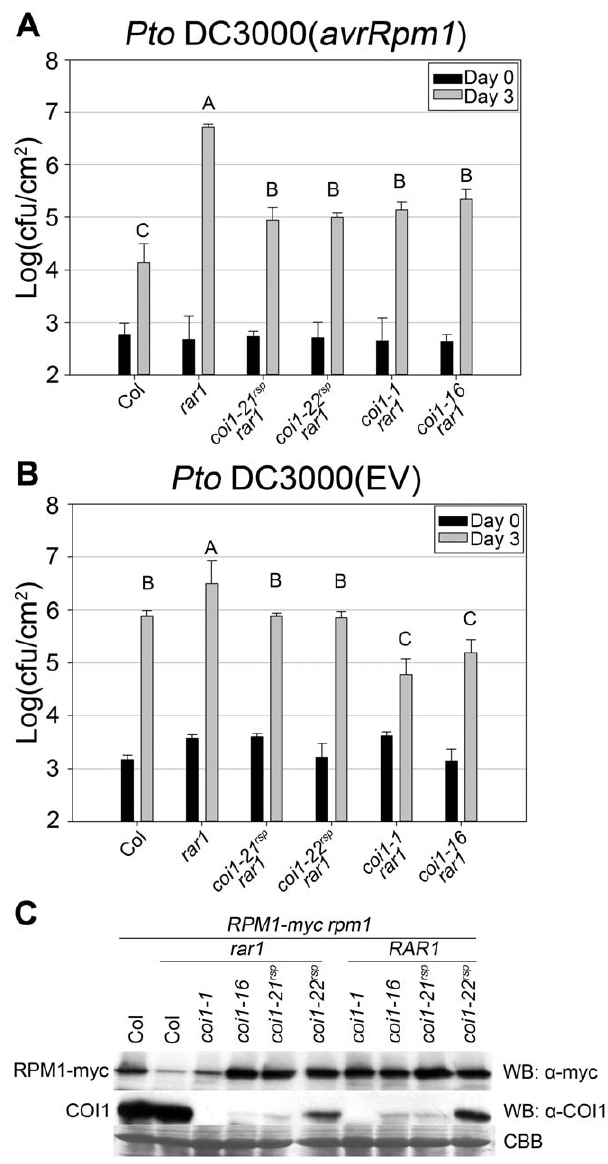
Figure 3. coi1 rsp mutants suppress rar1 phenotypes and are not null allele. (A–B) Bacterial growth analysis of (A) Pto DC3000( avrRpm1 ) and (B) Pto DC3000(EV). Bacteria were hand-infiltrated into leaves of each indicated genotype and counted at day 0 and day 3. Error bars represent 2 6 SE. Pairwise comparisons for all means for bacterial growth on day 3 were performed with One-Way ANOVA test followed by Tukey-Kramer HSD at 95% confidence limits. (C) Western blot analysis of RPM1-myc and COI1 levels in the indicated genotypes. RuBisCo levels stained by Coomassie Brilliant Blue serve as loading controls. The pathogen growth assays were performed independently three times with similar results. The western blots were performed independently two times with similar results. Both RPM1-myc and COI1 blots used the same protein samples. mRNA levels among the tested coi1 mutants (Figure S4), indicating that the coi1 rsp and coi1-16 alleles restore RPM1 protein levels by a post-transcriptional mechanism in rar1 .